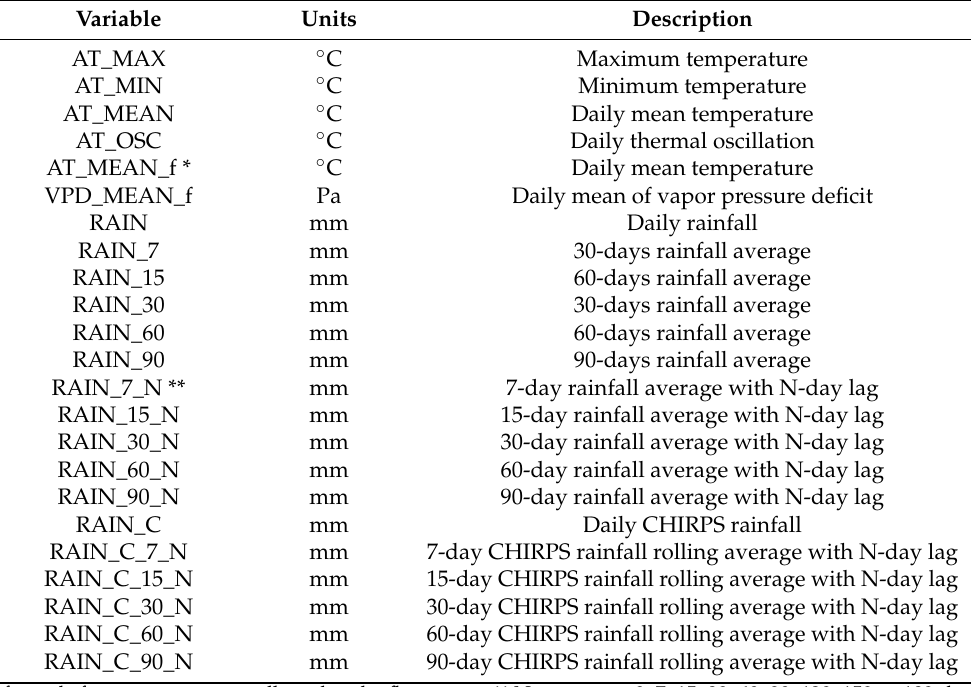
Table 4. Environmental drivers of primary productivity used for the empirical model formulations. Variable Units